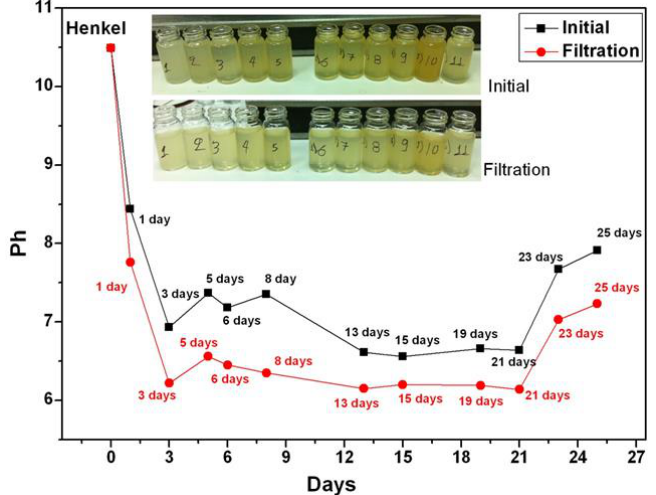
Figure 3. pH measurement before (black) and after (red) the additional coolants’ filtration for the Henkel Multan 61-3DF. A clear reduction of the pH index for the filtered coolant is noticeable.